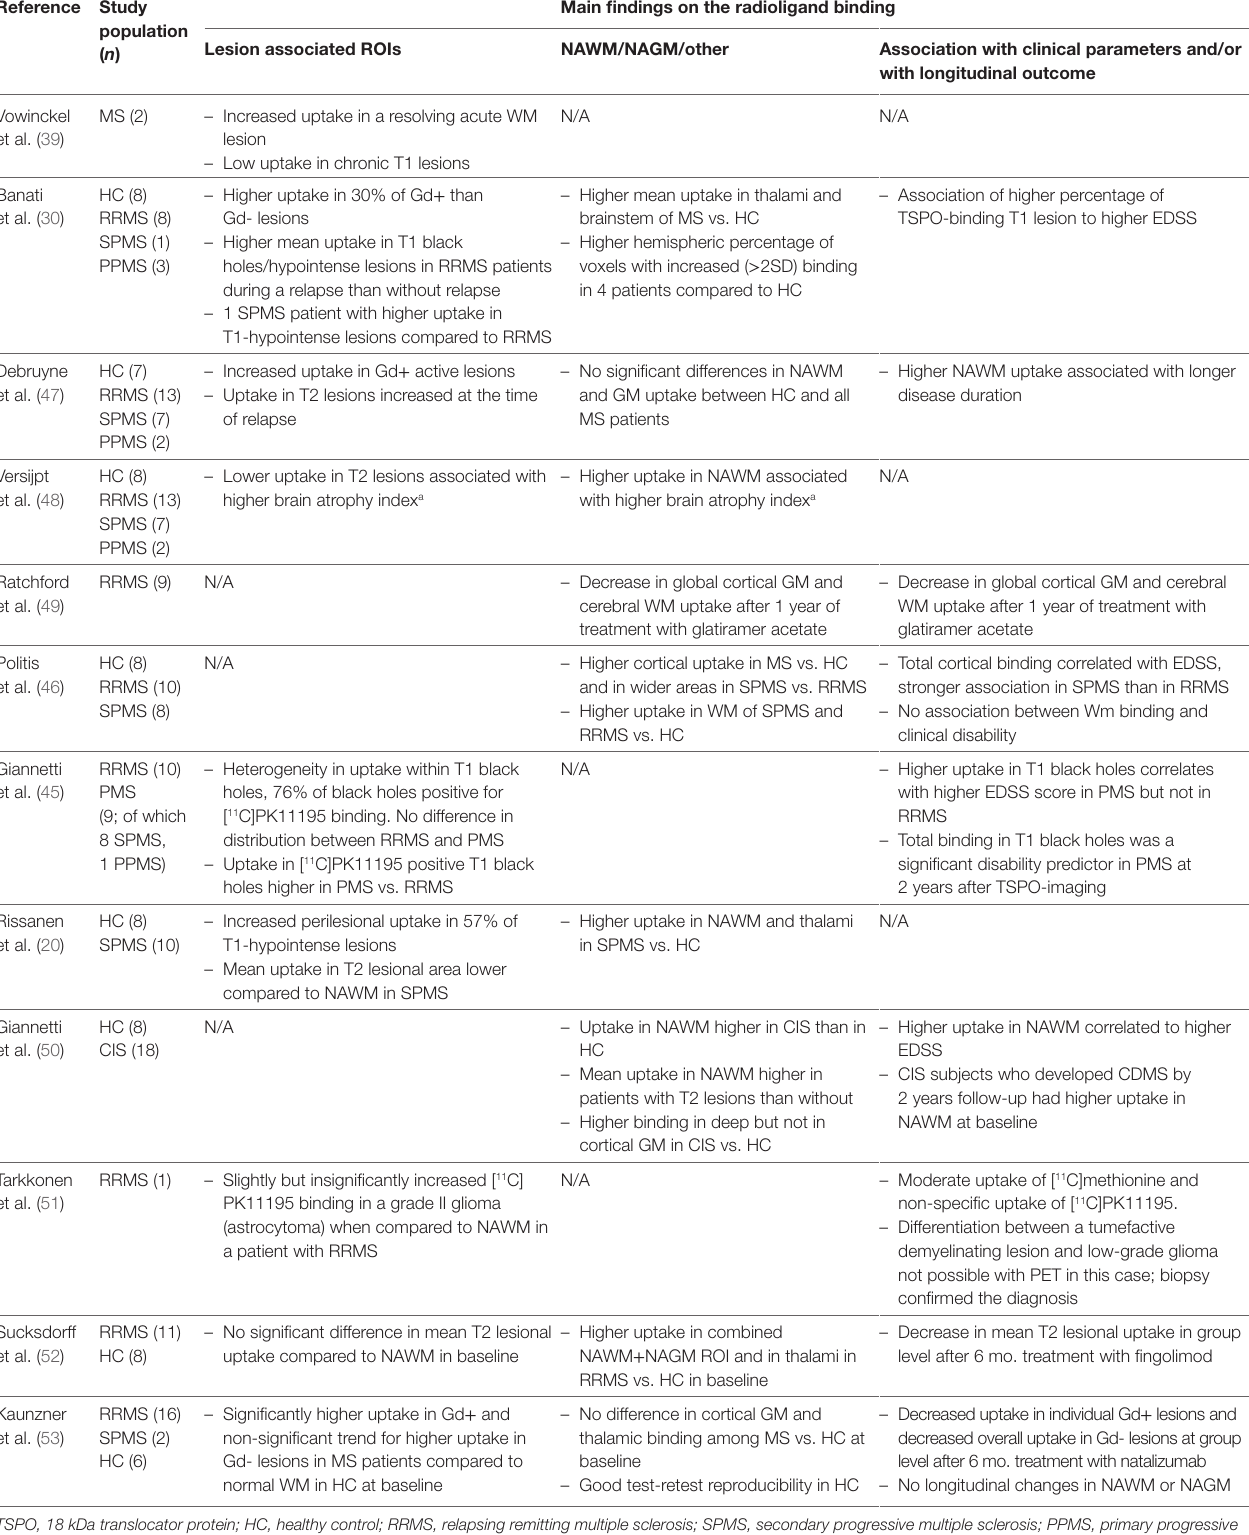
TABLe 1 | Human in vivo positron emission tomography (PET) imaging studies with first generation TSPO ligand [ 11 C]PK11195 in multiple